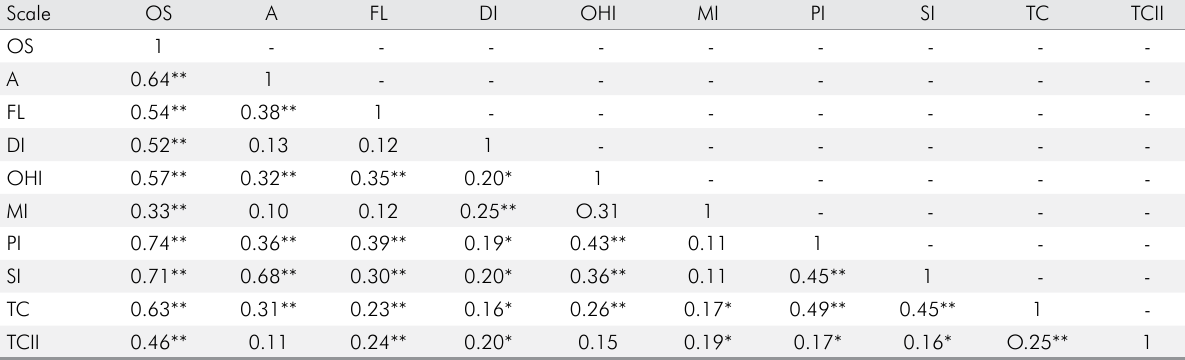
Table 3. Construct validity: Pearson correlation of the Brazilian version of the IFAM Scale